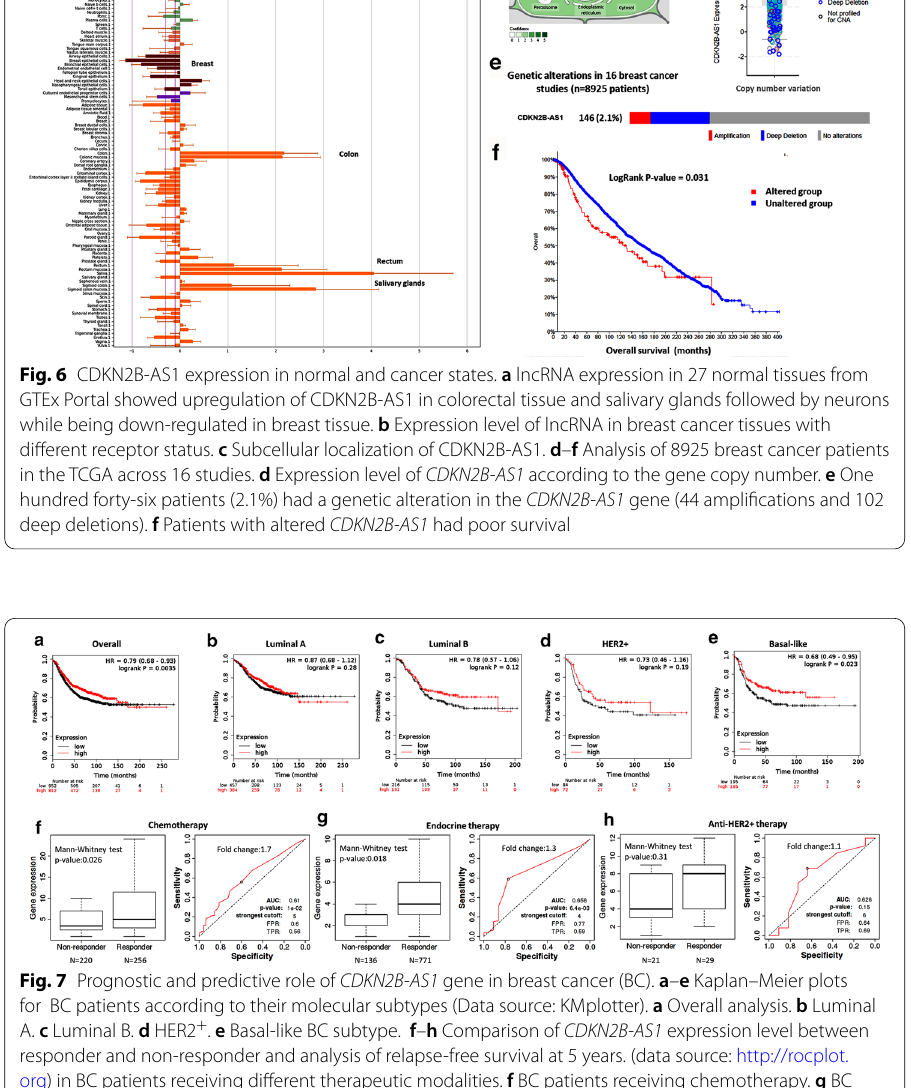
We used CHAT to analyze PubMed literature on BC and our studied gene. Cell inva- sion and metastasis was the most common hallmark associated with BC literature, followed by sustaining proliferative signaling. CDKN2B-AS1 studies have two main hall- marks similar to those of the BC profile: sustaining proliferative signaling and genome instability and mutation (Fig. 9b). Upstream regulators enhancing transcription of the